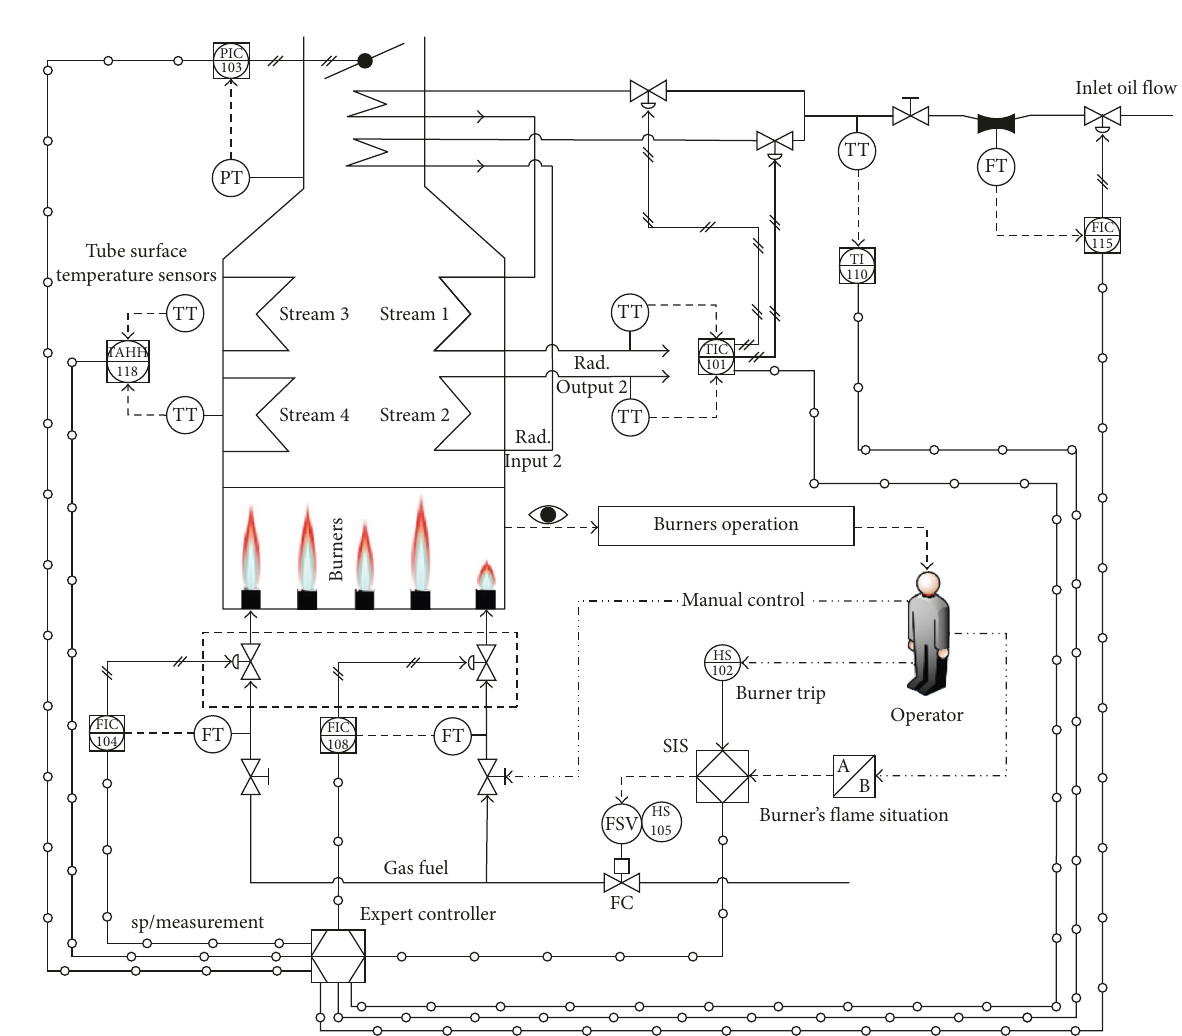
Figure 5: A schematic of control system configuration for a fired-heater furnace